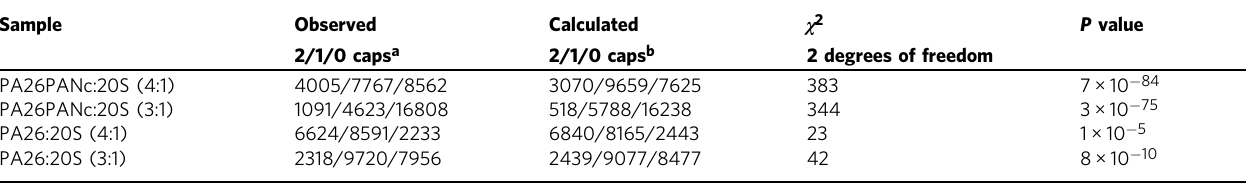
Table 3 Cooperative association of 20S CP with PA26PANc or PA26.